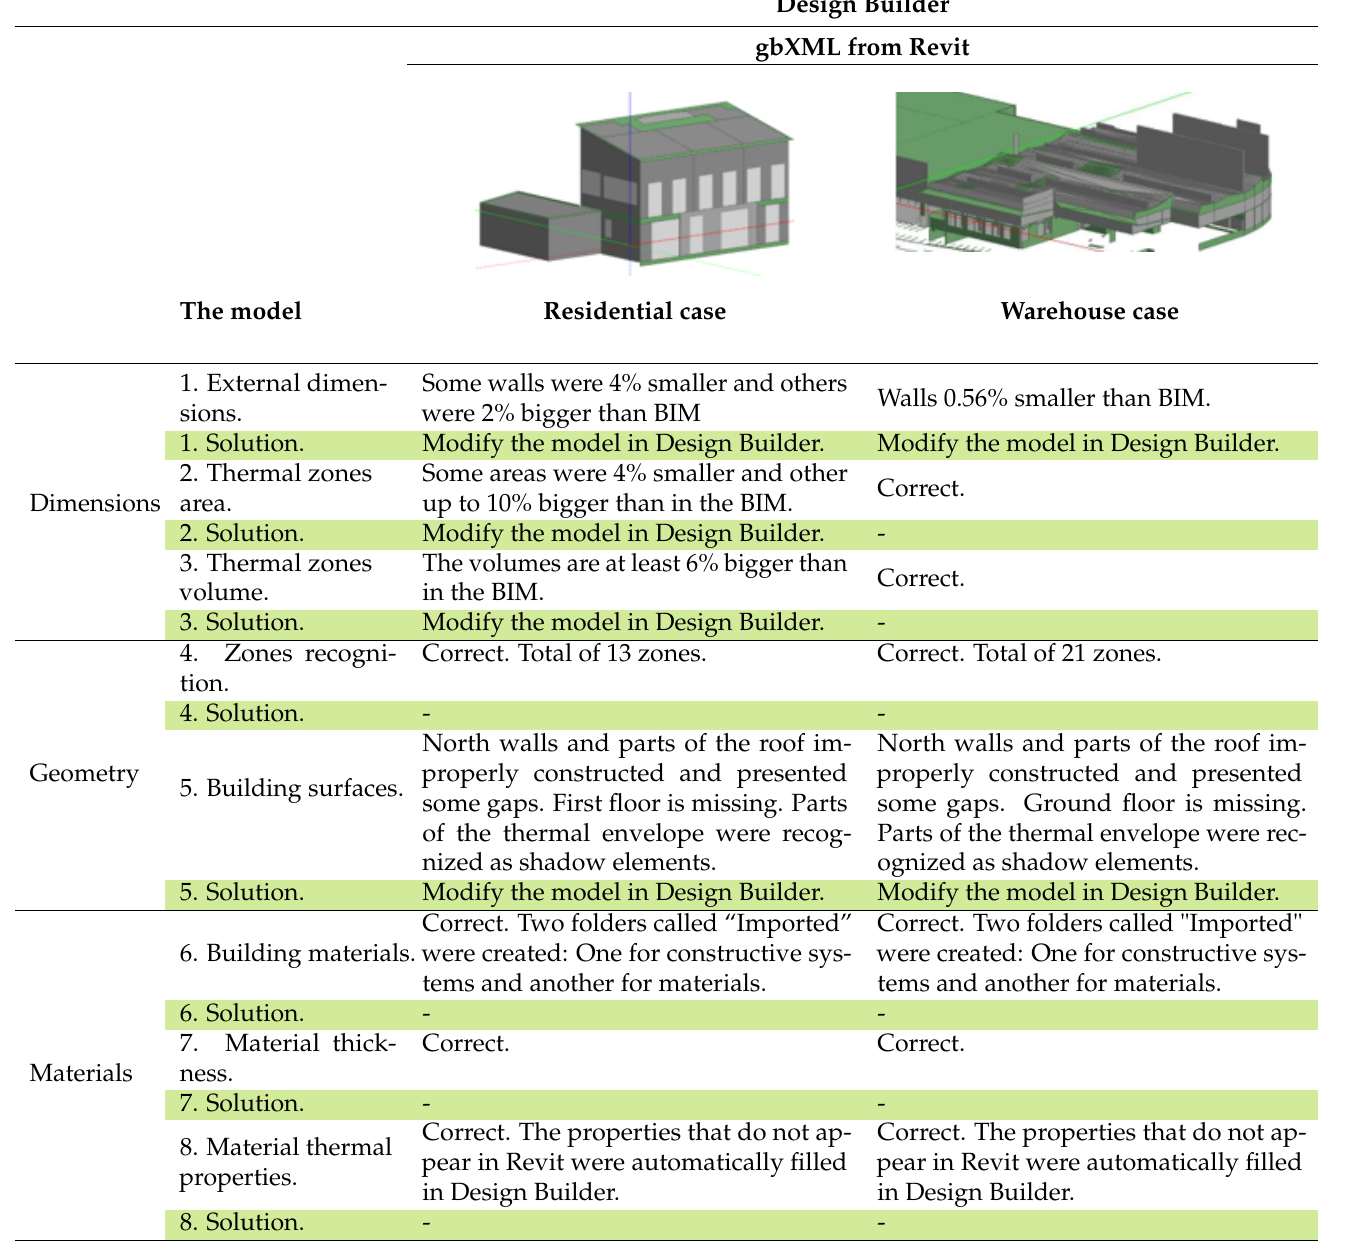
Table 1. Comparative table between the gbXML files imported in Design